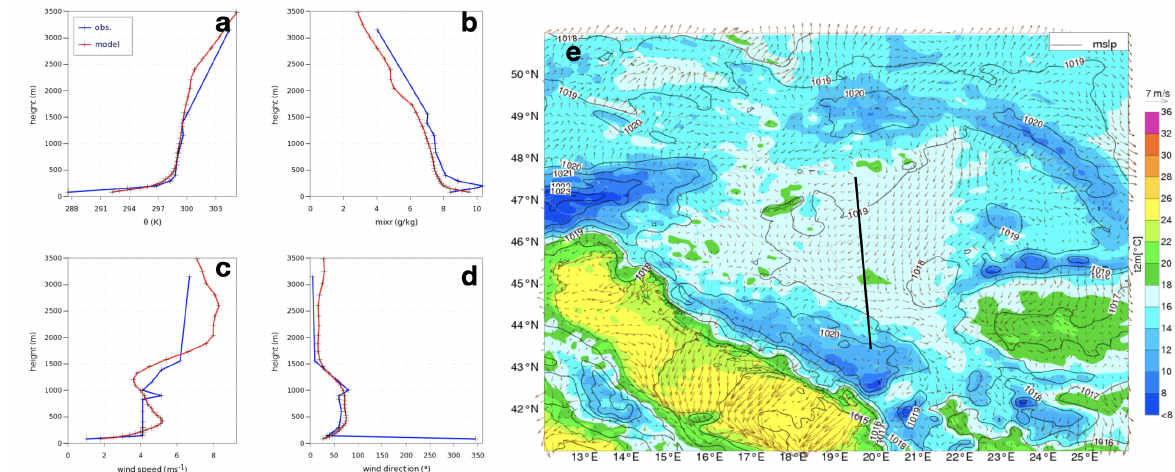
Figure 7. Summer clear skies cold air pool (2–3 September 2016): ( a ) radiosounding (blue) and ECMWF profile (red) at Szeged Airport at 00 UTC (blue) for potential temperature, ( b ) water vapour mixing ratio, ( c ) wind speed, and ( d ) wind direction; ( e ) temperature at 2 m and wind at 10 m in ECMWF output at 05 UTC, near sunrise. The black line indicates the location of the vertical cross-sections in Figures 8 and 9.